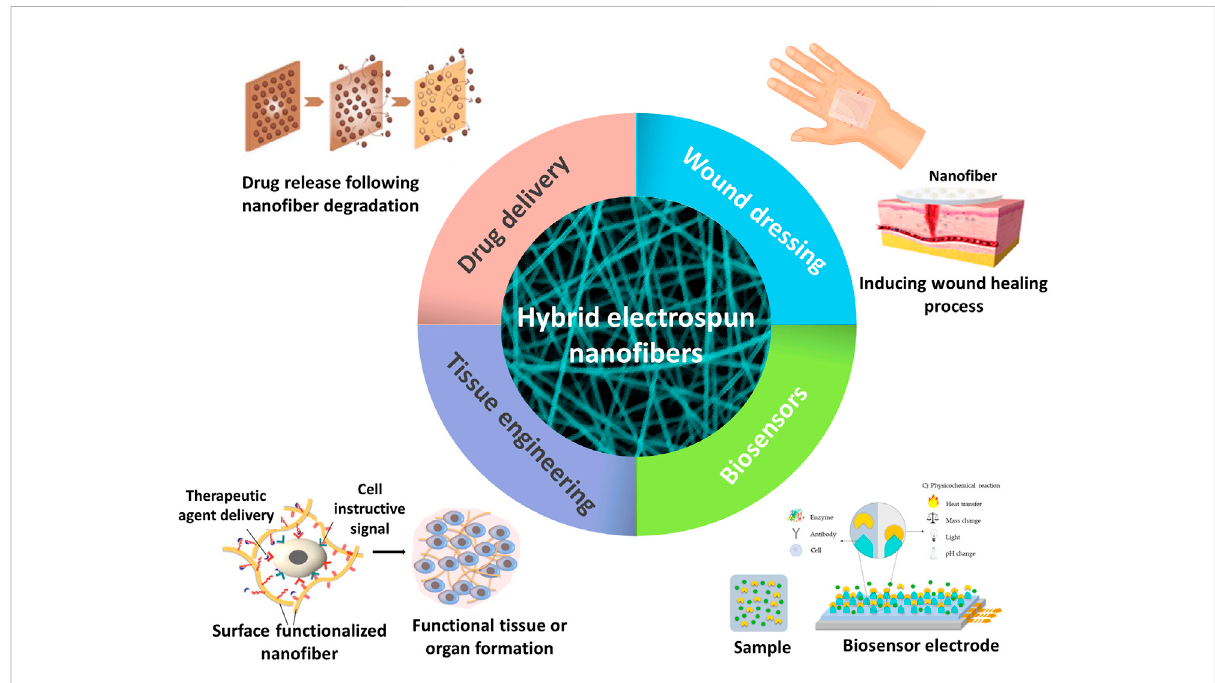
FIGURE 3 Various applications of hybrid electrospun nano fi bers in biomedical fi